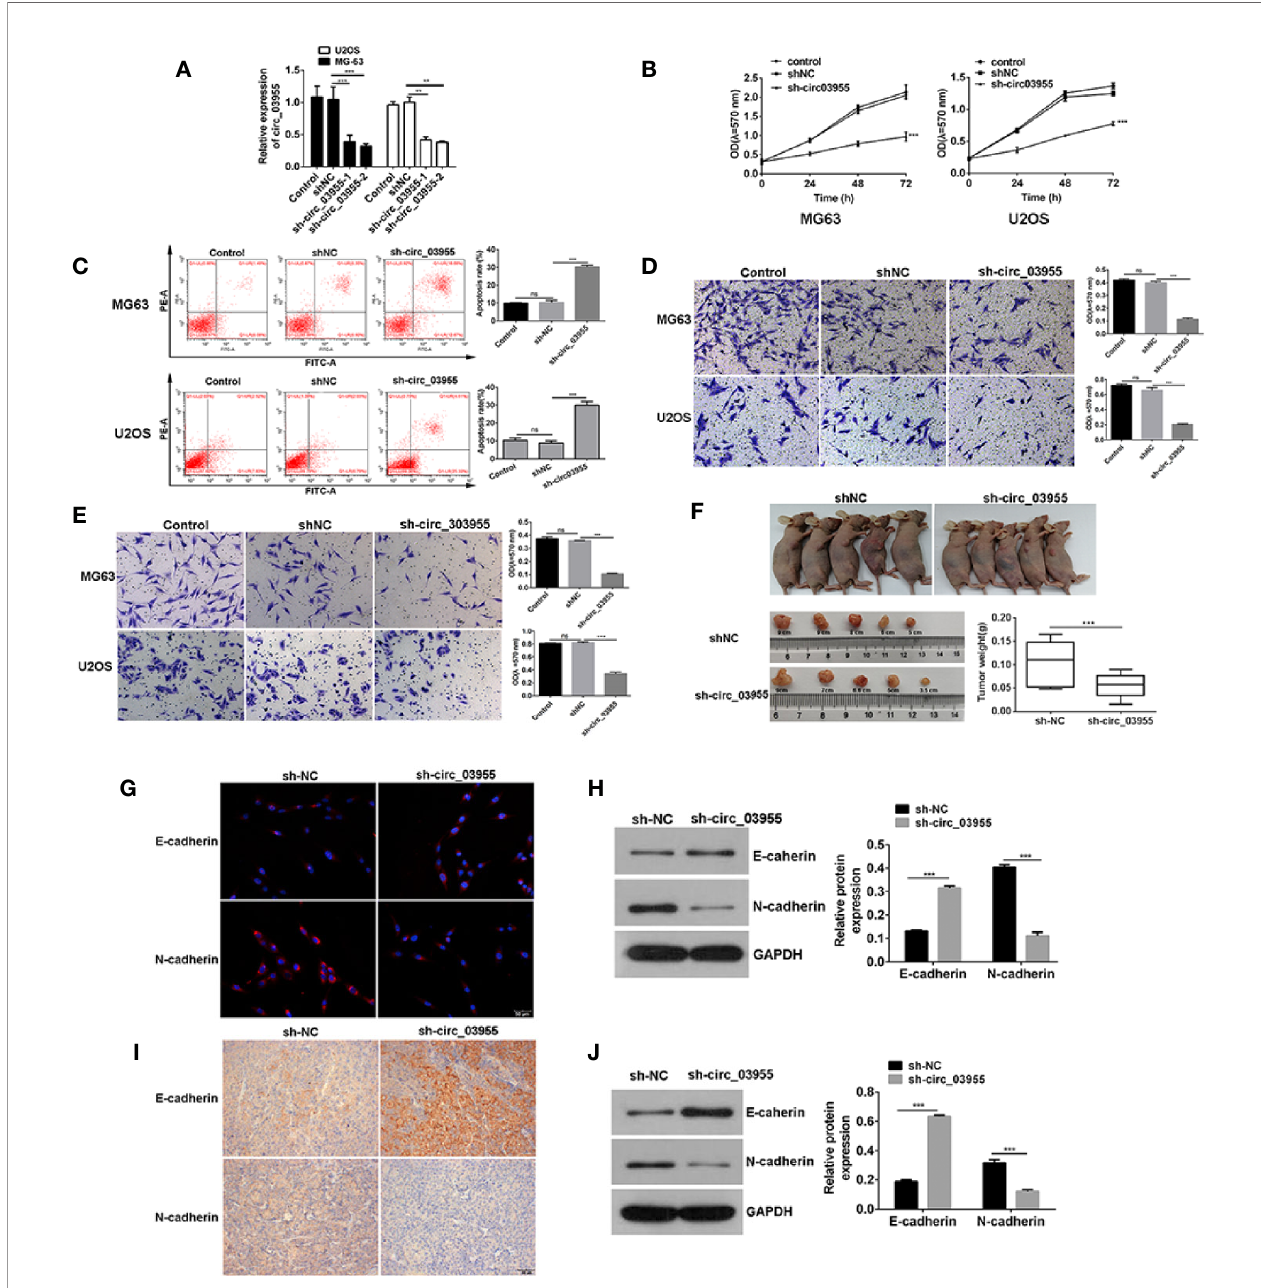
FIGURE 2 | Circ-03955 silencing suppressed osteosarcoma cells progression in vivo and in vitro . (A) qRT-PCR was used to verify whether sh-circ-03955 was successfully transfected into osteosarcoma cells in MG-63 and U2OS. (B) MTT assay was used to detect the effects of sh-circ-03955 on the proliferation of osteosarcoma cells in MG-63 and U2OS at 24, 48, and 72 hours after transfection. (C) Flow cytometry was used to detect the effect of sh-circ-03955 on the apoptosis of osteosarcoma cells in MG-63 and U2OS 48 hours after transfection. (D) Transwell assay was used to detect the effects of sh-circ-03955 on the migration of osteosarcoma cells in MG-63 and U2OS at 48 hours. (E) Transwell assay was used to detect the effect of sh-circ-03955 on invasion of osteosarcoma cells in MG-63 and U2OS at 48 hours. (F) Size and weight of transplanted tumors. (G) The expression of E-cadherin and N-cadherin in osteosarcoma MG-63 cells transfected with sh-NC and sh-circ-03955 for 48 hours was detected by immuno fl uorescence. (H) Western blotting was used to detect the expression of E-cadherin and N-cadherin in osteosarcoma MG-63 cells transfected with sh-NC and sh-circ-03955 for 48 hours. (I) After transfection of osteosarcoma MG-63 cells with sh-NC and sh-circ-03955, the tumorigenesis experiment was carried out in nude mice, and the transplanted tumor tissues were removed and immunohistochemical assays were performed. (Scale bar = 500 m m, 200×) (J) After transfection of osteosarcoma MG-63 cells with sh-NC and sh-circ-03955, the tumorigenesis experiment was carried out in nude mice, and the transplanted tumor tissues were removed for Western blot detection. Data are presented as the mean ± standard deviation of three independent experiments, NS, not signi fi cant, ** p < 0.01, *** p < 0.001 vs. shNC